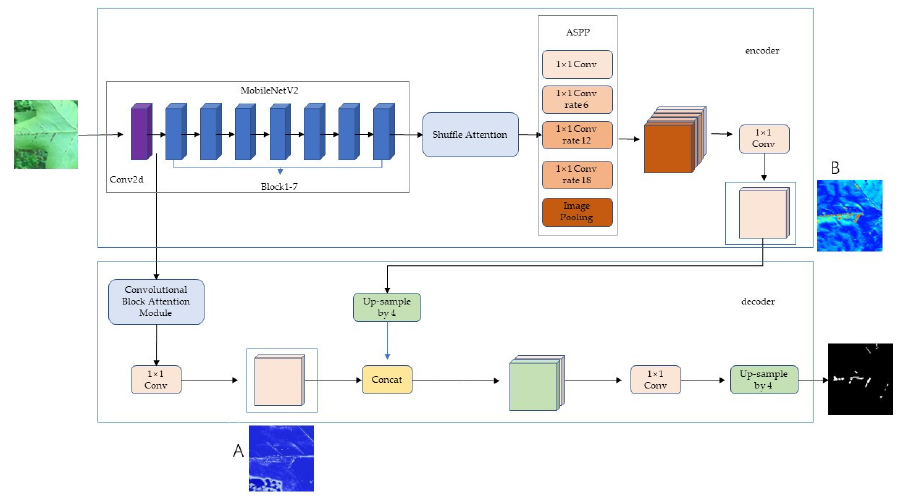
Figure 7. Structure diagram of improved DeepLabV3+ model. (A) and (B) are feature